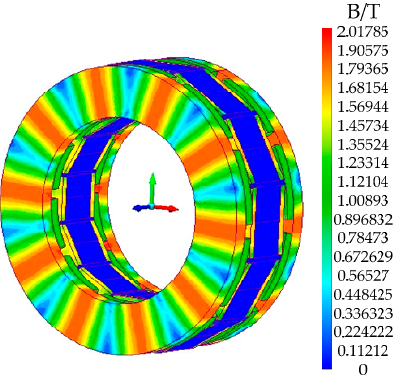
Figure 4. The distribution of no-load flux density of yokeless and segmented armature axial flux motor.